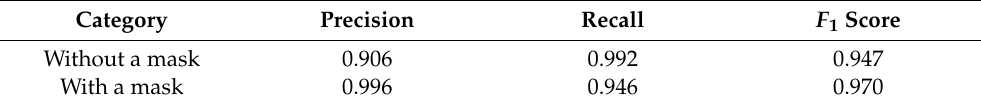
Table 1. Detection results of whether or not to wear